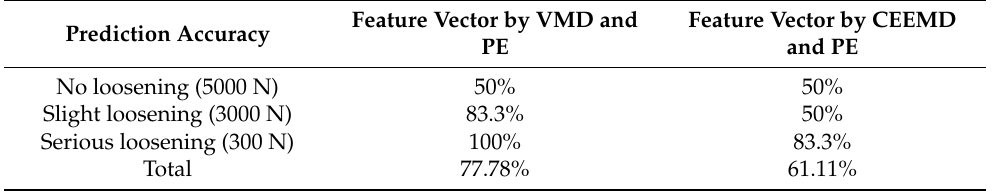
Table 4. Prediction accuracy under the